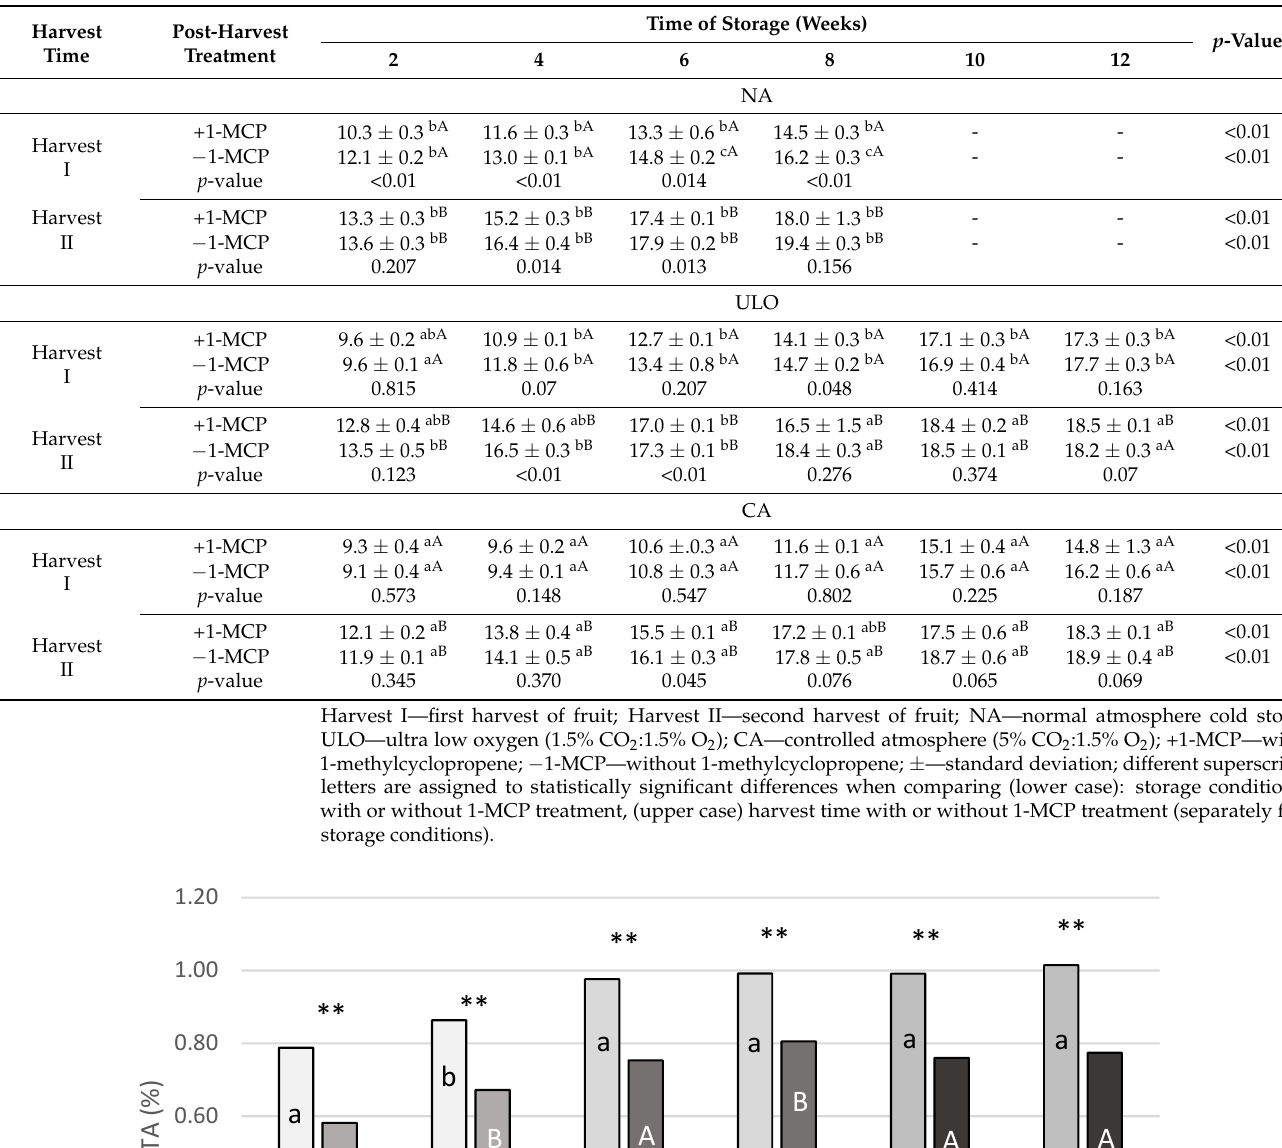
Table 5. Changes of solids soluble content ( ◦ Brix) measured in ‘Ananasnaya’ mini kiwi fruit in the post-harvest period.